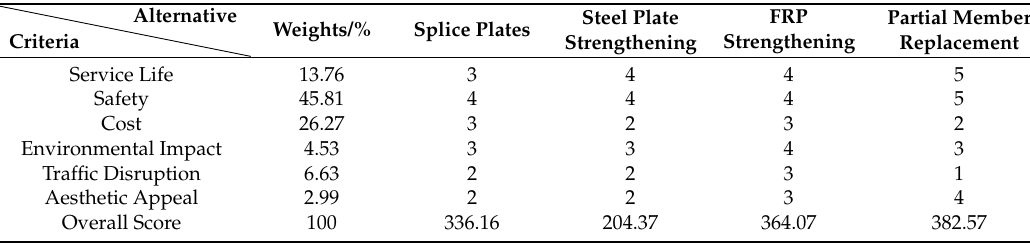
Table 5. Global Priorities of Different Major